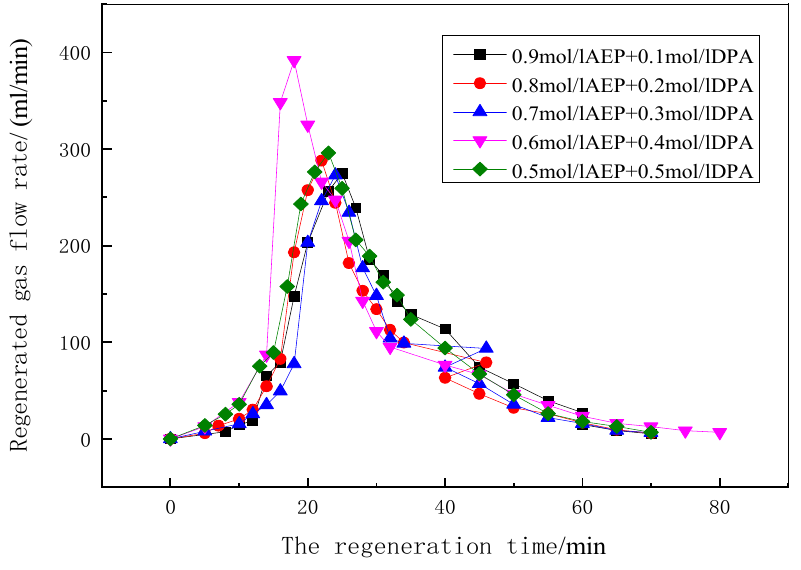
Figure 6. Relation curve between regeneration gas flow and desorption time of AEP-DPA system.